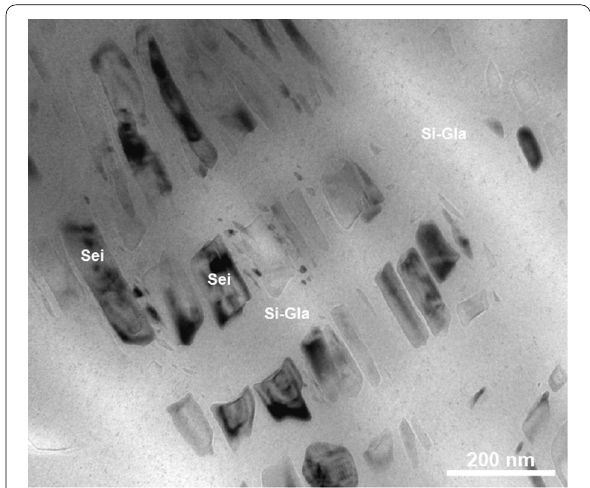
Fig. 11 BF-TEM image of seifertite in the basaltic lunar meteorite Northwest Africa (NWA) 4734. Lath-like seifertite crystals have formed in cristobalite grains in contact with the shock-melt veins of NWA 4734. Most parts of the original cristobalite grains have become amorphous. Sei: seifertite, Si-Gla: